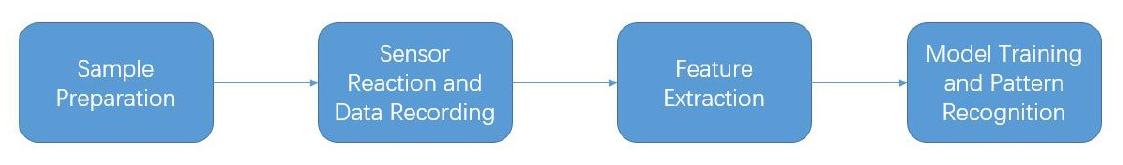
Figure 1. Research